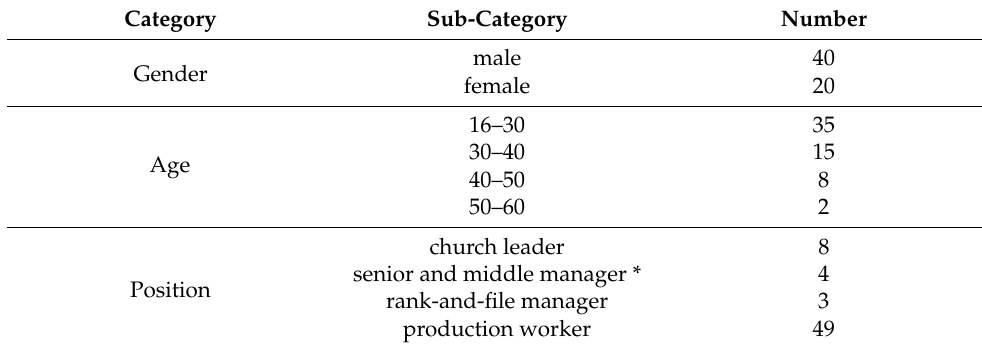
Table 1. Demographic information of